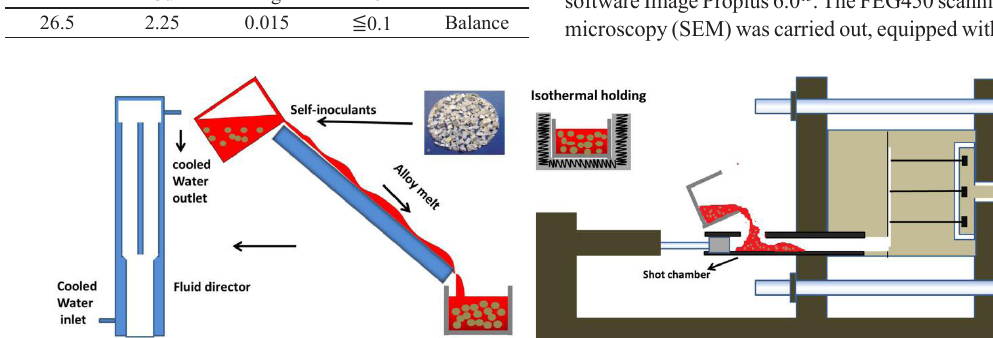
Figure 1. Schematic diagram of SIM (Self-inoculation Method) rheo-diecasting process.